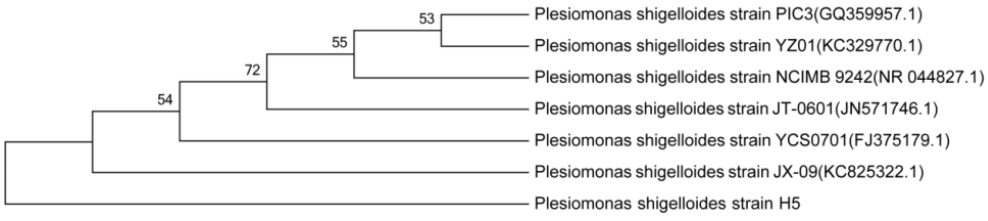
Figure 1. Phylogenetic tree for 16SrDNA gene sequences of P. shigelloides H5. Table 2. Morphological and biochemical characteristics of P. shigelloides